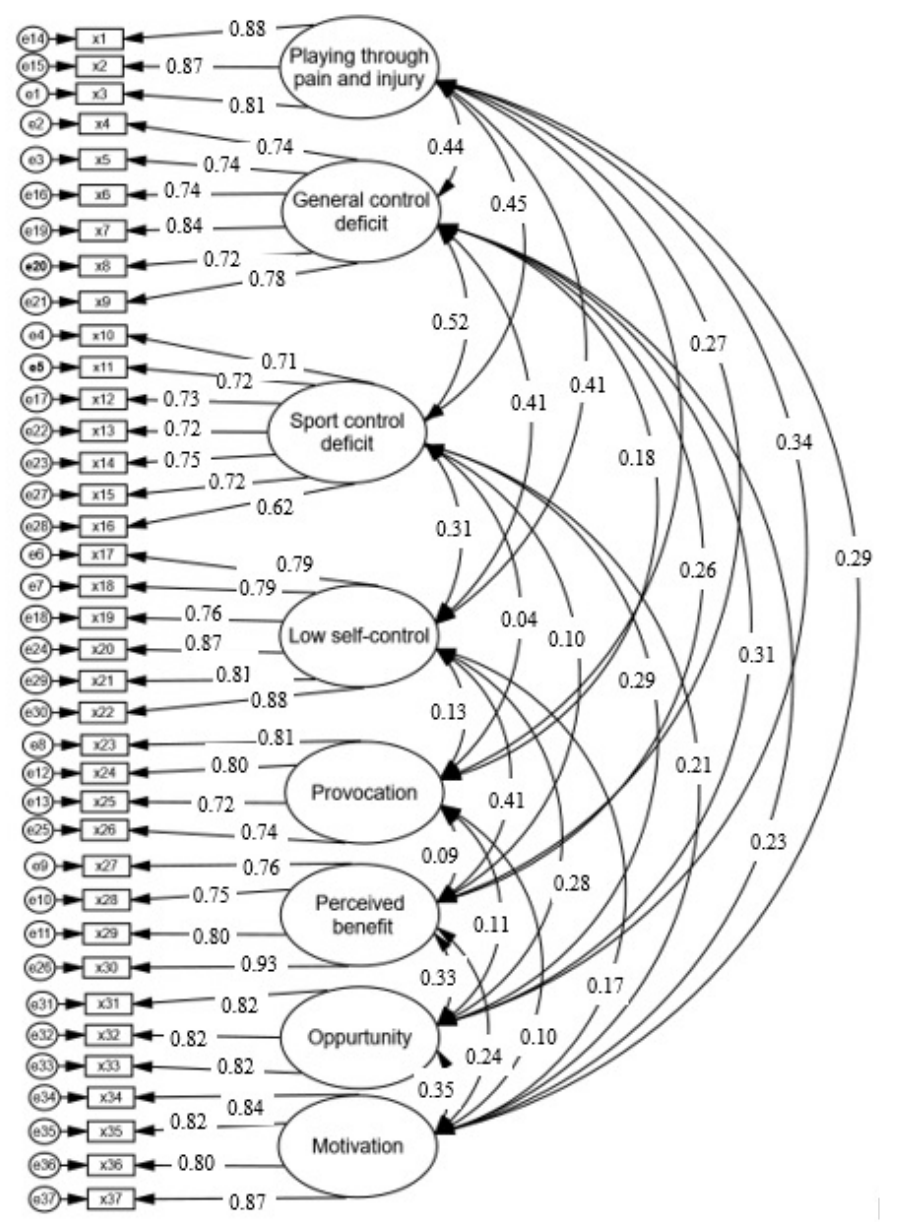
Figure 2. Confirmatory factor analysis model.